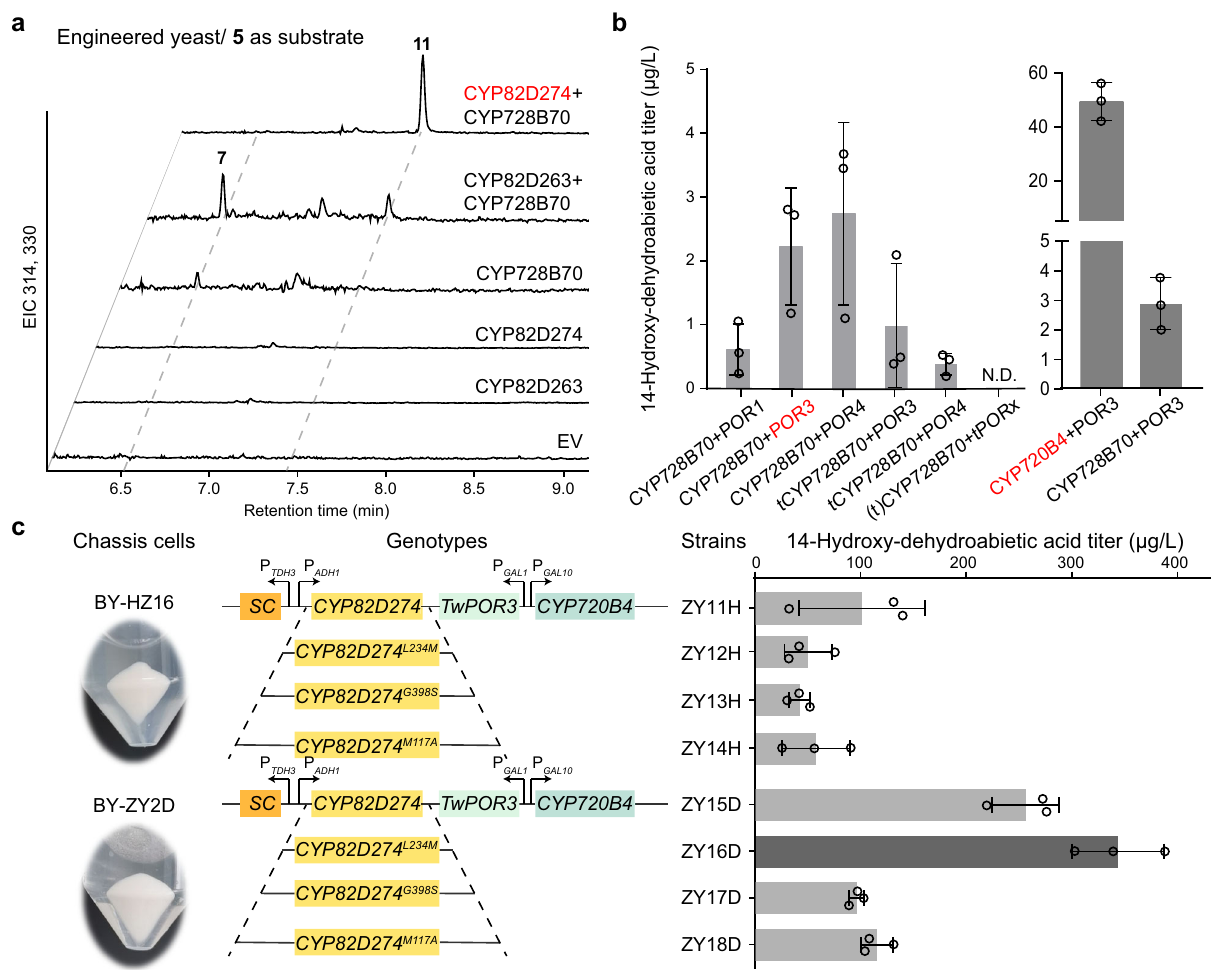
Fig. 6 | De novo biosynthesis of 14-hydroxy-dehydroabietic acid (11) in yeast. a GC ‒ MS analysis of methylated products in CYP82D274 and CYP82D263 coex- pressed with CYP728B70. b Screening for optimal combinations of CYP and TwPOR.Optimalgenes are marked in red.N.D.indicates notdetected. c Yieldof 11 in the engineered strains. The images show the biomass of haploid and diploid